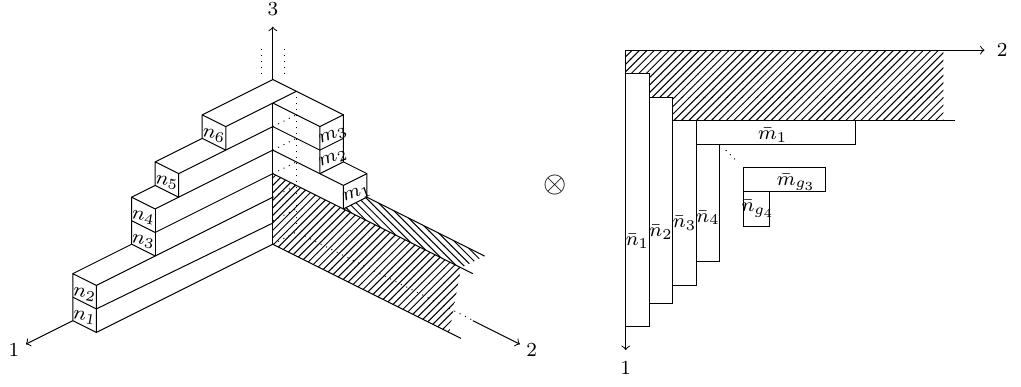
Figure 4 . The (cid:12)gure represents the state in the form of (3.5) with g 1 (cid:0) g 2 = g 4 (cid:0) g 3 > 0. The rows with in(cid:12)nite length and height g 1 (cid:0) g 2 are inserted. The above case corresponds to g 1 (cid:0) g 2 =